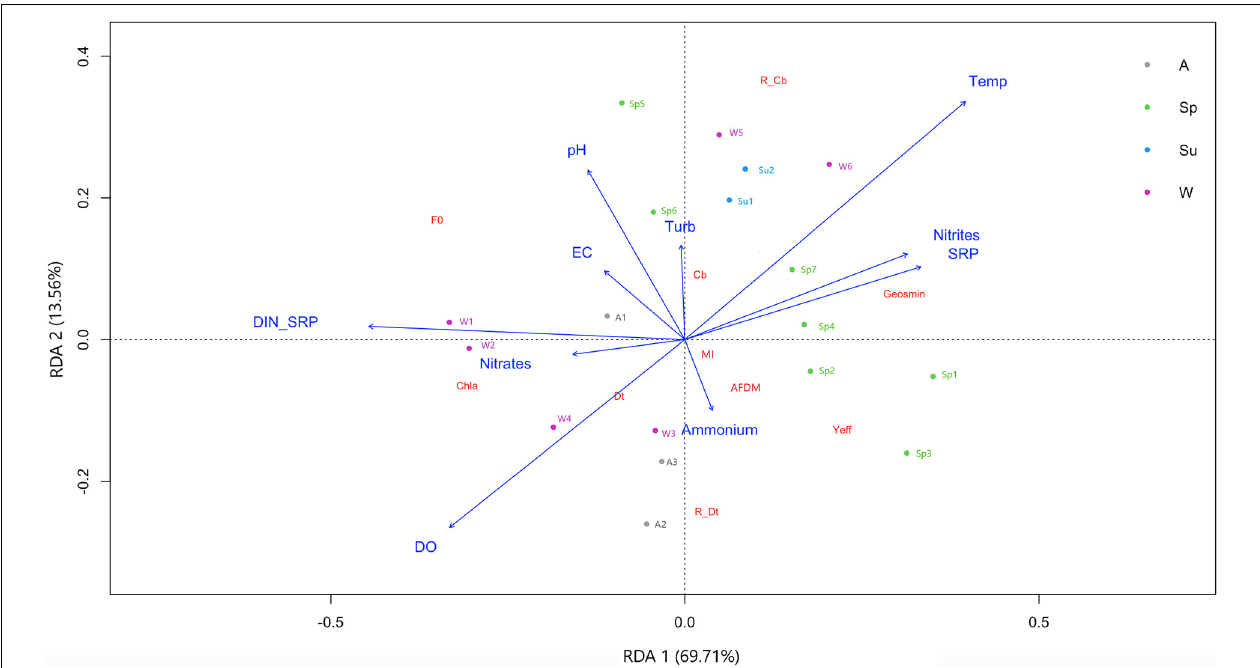
FIGURE 4 | Redundancy discriminant analysis showing biological parameters distribution at T4 sampling site based on physicochemical variables evaluated in upper Ter River basin (NE Catalonia, Spain) in 2019. Axes 1 and 2 combined explain 83.3% of variance. Seasons are winter (W), spring (Sp), summer (Su), and autumn (Au). Drivers: pH, temperature (Temp), electrical conductivity (EC), dissolved oxygen (DO), turbidity, nitrite (N-NO 2 − ), nitrate (N-NO 3 − ), ammonium (N-NH 4 + ), and phosphate concentration (P-PO 4 − 3 ), and nitrogen to phosphorus ratio (DIN:SRP). Response variables: geosmin, minimum fluorescence yield ( F 0 ), photosynthetic efficiency (Y eff ), chlorophyll- a concentration (Chl a ), ash free dry mass (ADFM), Margalef index (MI), cyanobacteria (Cb), diatoms (Dt) and green algae (GA) biomass, and relative abundance of cyanobacteria (R_Cb) and diatoms (R_Dt).